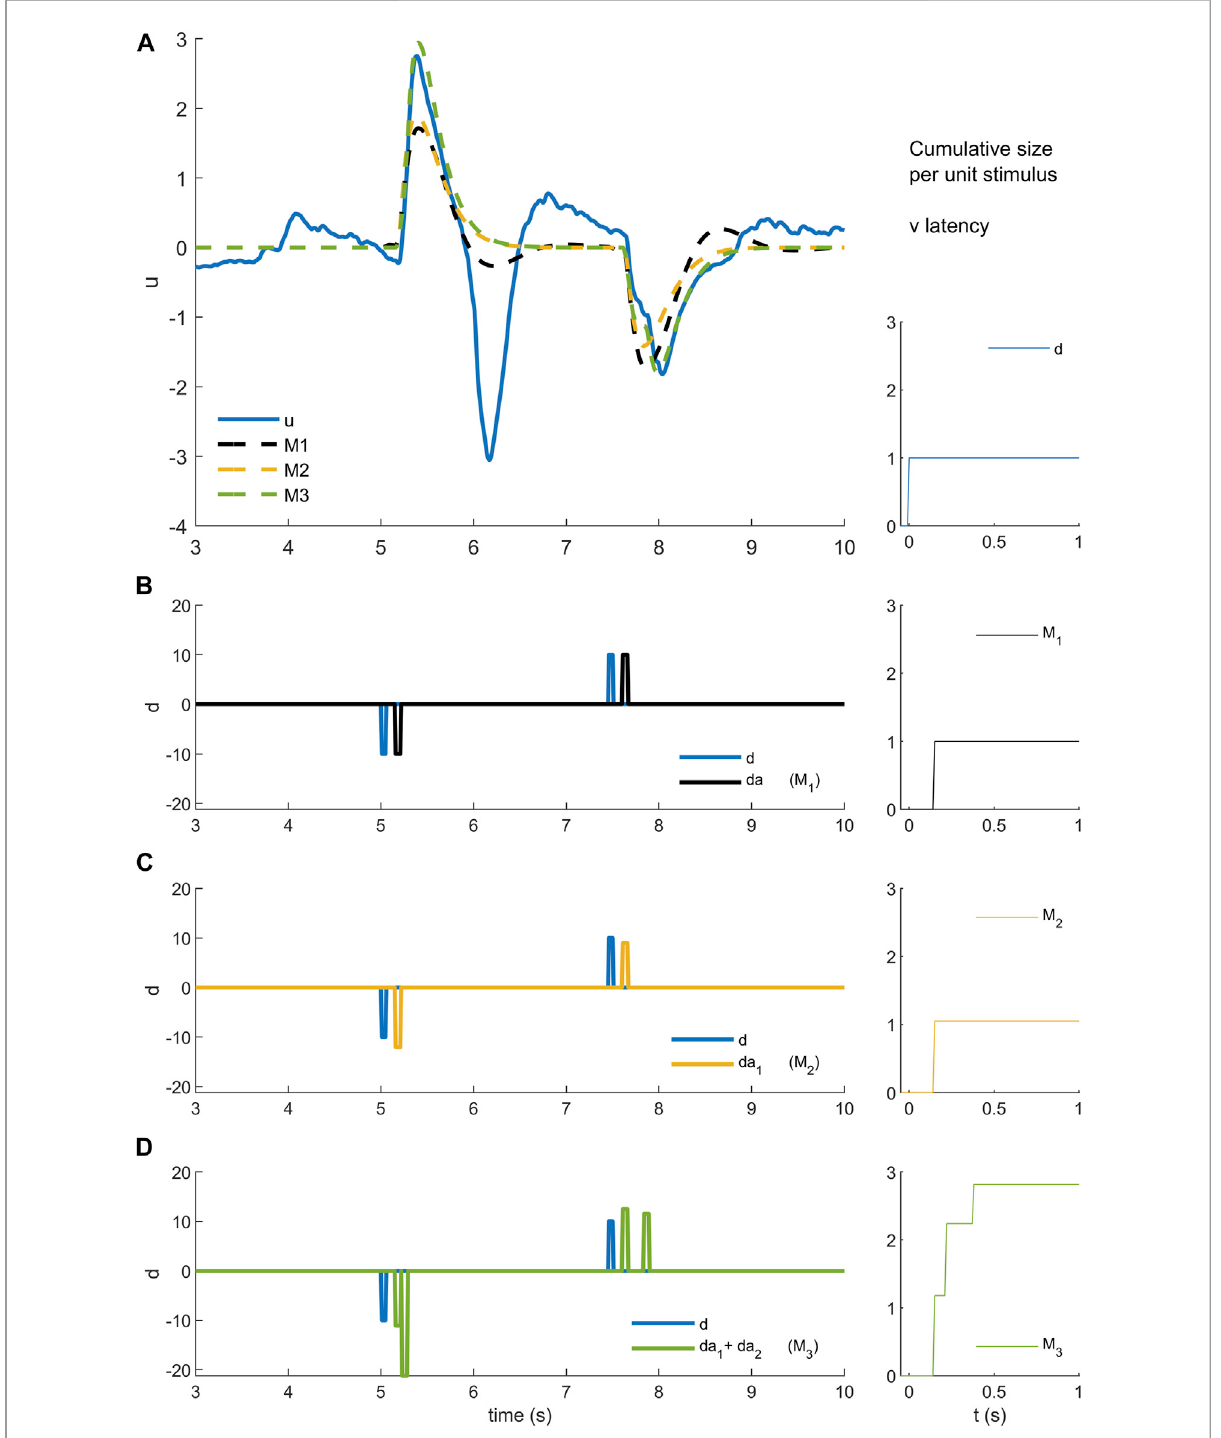
Models M1-3 (A) . Experimental control signal u and model (M1-3) simulated control signals. (B) . Disturbance d (blue) and model disturbance da (black) for model M1. (C) . Disturbance d (blue) and model disturbance da = da1 (yellow) for model M2. (D) . Disturbance d (blue) and model disturbance da = da1 + da2 (green)for model M3. Right column. Cumulative size of model simuli versus latency. Rows A-B show experimental stimulus (blue), M1 model stimulus (black), M2 model stimulus (yellow) and M3 stimulus (green)). Message: Non-linearity is modelled by reforming and optimizing the disturbance sequence applied to an ARX model structure. Detail: An ARX model is a general representation of a linear system with historical states stimulated by adisturbance and stimulated by random noise. The ARX model can be thought of as system such as a